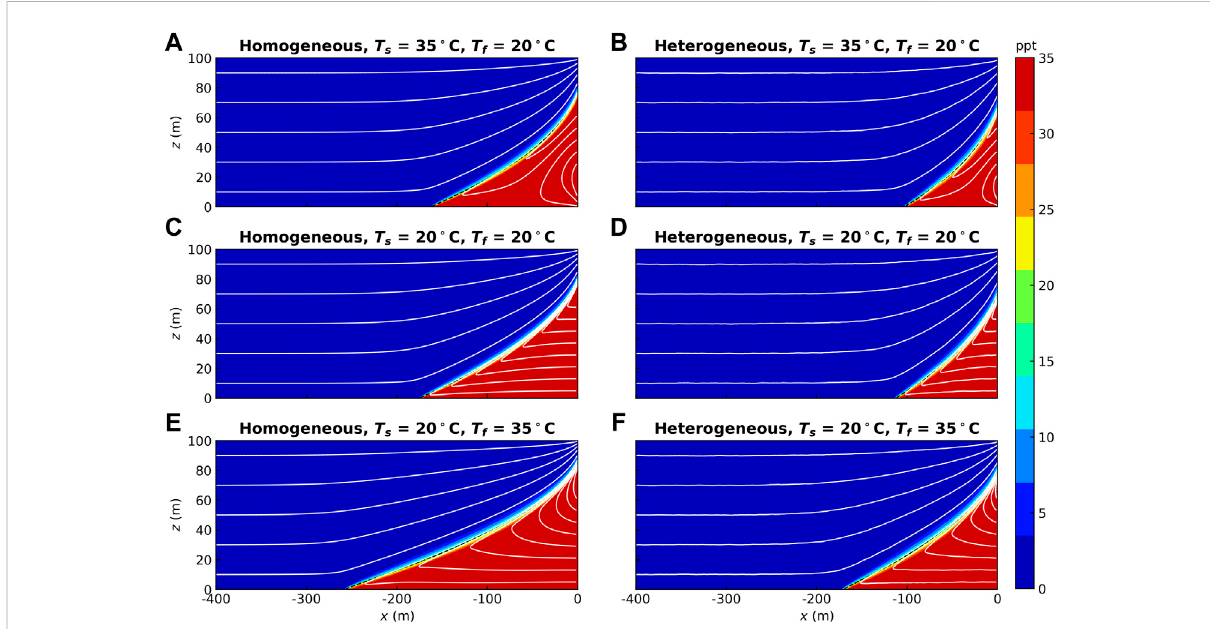
FIGURE 3 Salinity distributions in coastal aquifers subjected to different FW-SW temperature contrasts. The left-hand (A, C, E) and right-hand (B, D, F) panels are the results for homogeneous and heterogeneous aquifers, respectively. The results for heterogeneous aquifers ( σ 2 ln k = 1 and λ x = 0.5 m) are averaged ( n = 50). The black dashed lines are the 50% seawater concentration isohalines (17.5 ppt), i.e., the FSI. The white lines show fl ow streamlines. T s and T f are seawater and freshwater temperatures, respectively.